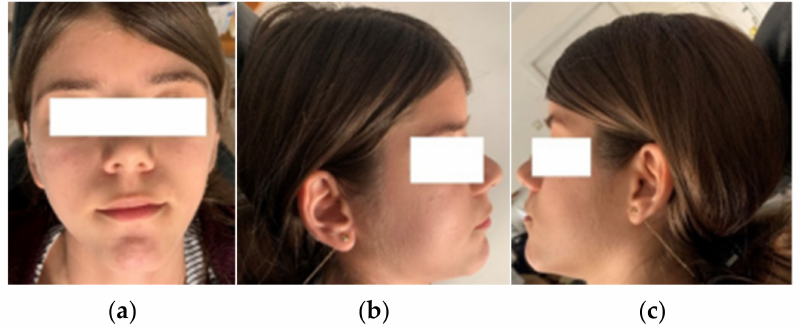
Figure 1. Front ( a ), right ( b ), and left ( c ) profile photos of the patient.